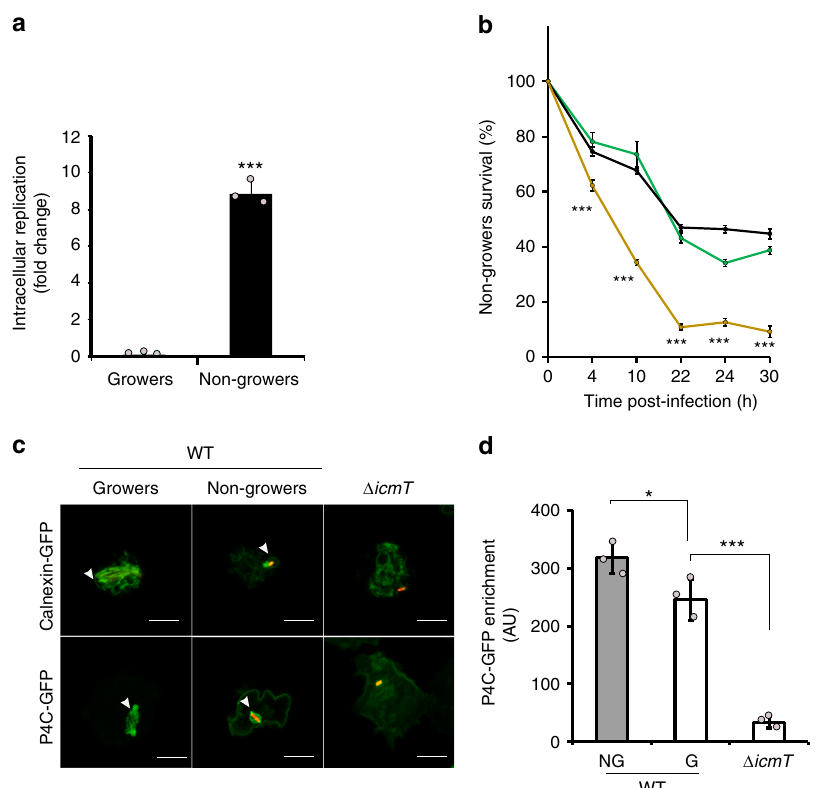
Fig. 4 Intracellular L. pneumophila nongrowers are highly virulent. a Intracellular nongrowers are virulent. A. castellanii were infected (MOI 1, 24 h) with L. pneumophila /Timer, lysed and FACS-sorted according to the Timer green/red color ratio. Sorted growers and nongrowers were used to re-infect A. castellanii , and intracellular replication was determined by CFU (fold change: CFU 30min p.i. /CFU 96h p.i. ). b T4SS-dependent survival of intracellular nongrowers. A. castellanii were infected (MOI 1) with L. pneumophila wild-type (black), the isogenic avirulent Δ icmT strain (yellow) and the complemented strain Δ icmT ( icmTS ) (green) expressing timer . At given time points, the nongrowers from infected amoebae lysates were quanti fi ed by fl ow cytometry and analyzed by comparison with WT. c , d Intracellular nongrowers reside in individual LCVs. c D. discoideum amoebae producing the ER/LCV marker calnexin- GFP or the PtdIns(4) P probe P4C-GFP were infected (MOI 1, 24 h) with L. pneumophila /Timer WT or the Δ icmT /Timer strain, fi xed and analyzed by confocal microscopy. Micrographs show overlays of the fl uorescence at 500 nm (GFP, Timer) and 600 nm (Timer). White arrows show GFP-positive membrane only around intracellular WT growers and nongrowers. Scale bars 10 μ m. d D. discoideum /P4C-GFP was infected (MOI 1, 24 h) with